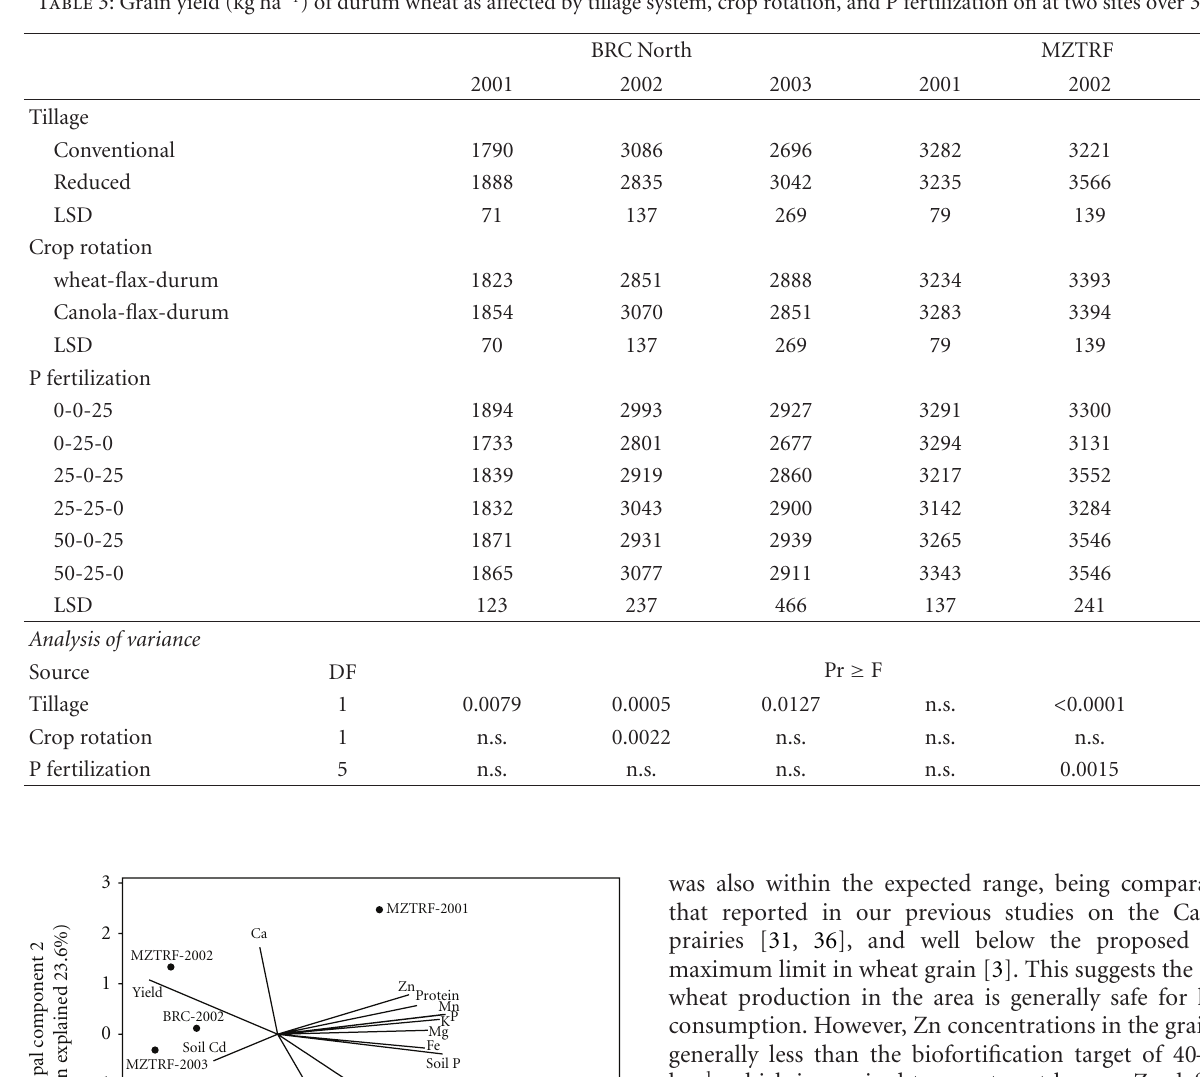
Table 3: Grain yield (kg ha − 1 ) of durum wheat as a ff ected by tillage system, crop rotation, and P fertilization on at two sites over 3 years.